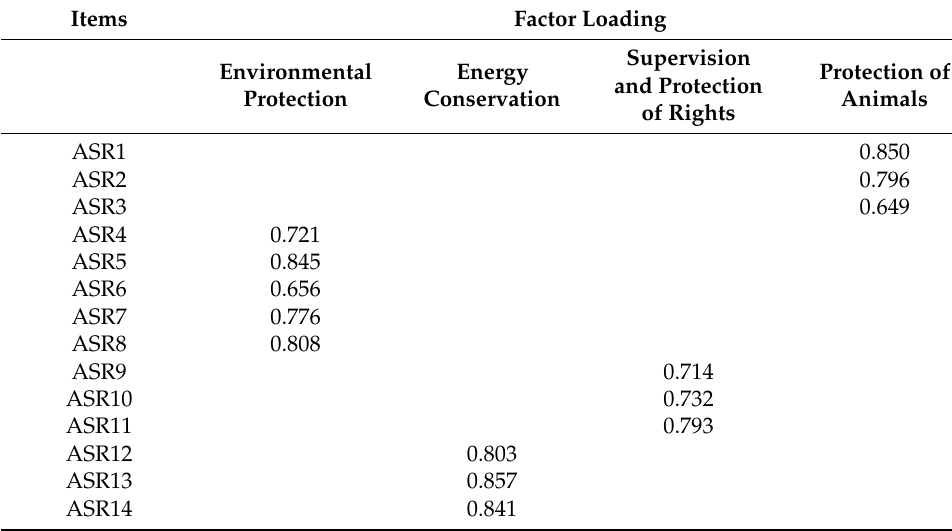
Table 2. Rotating component matrix of sense of social responsibility.